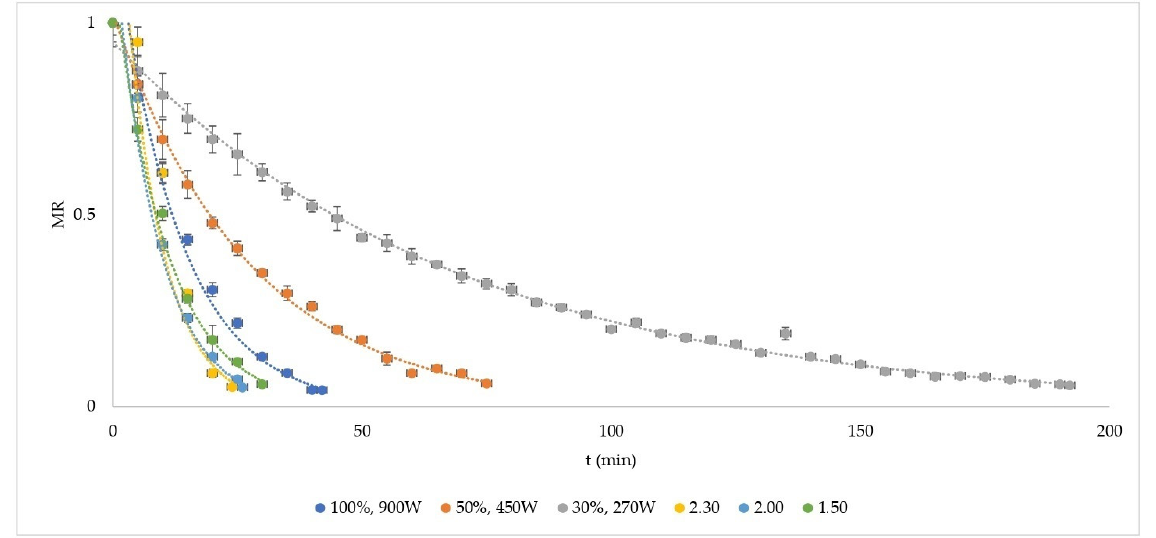
Figure 1. E ff ects of dehydration method (MD, MCD) on MR. Figure 1. Effects of dehydration method (MD, MCD) on